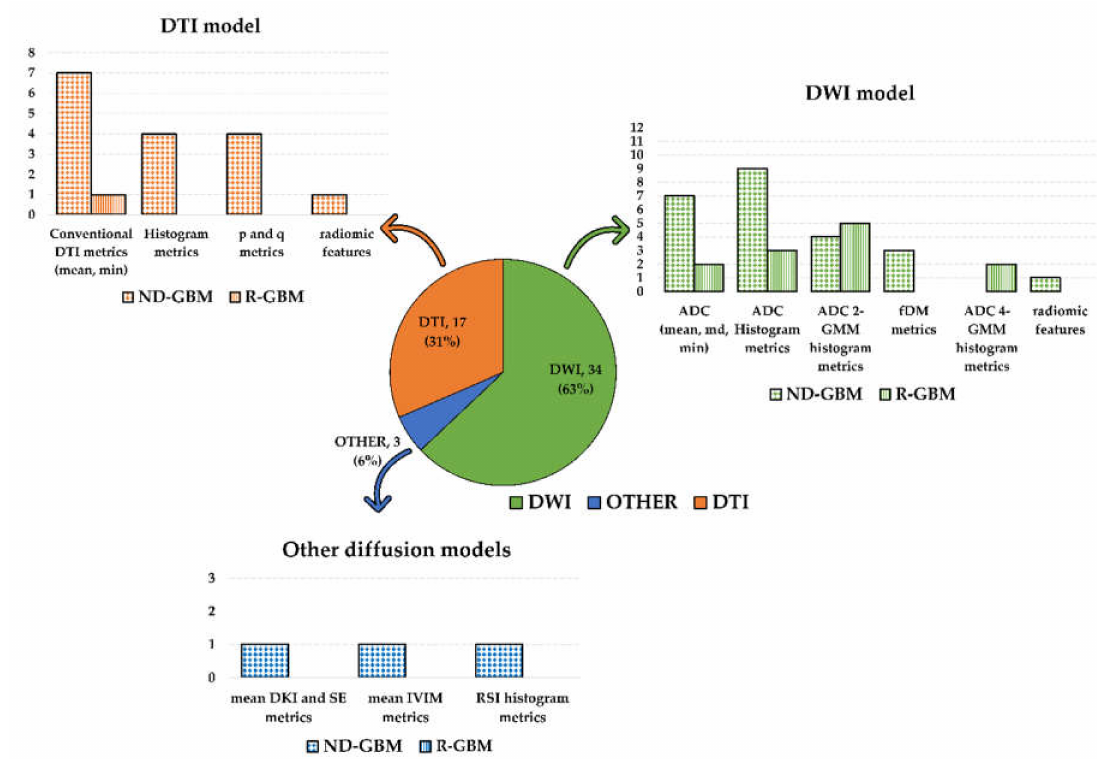
Figure 2. Graphic summary of the systematic review results according to the di ff usion models and metrics investigated in the selected studies. The pie chart shows the number of included studies according to the di ff usion MRI model (DWI in green; DTI in orange; other di ff usion models in blue). Number and percentage of studies included in each of the three groups were reported. The bar plots show the di ff usion metrics investigated in each group. Dotted bars count studies on newly diagnosed GBM patients, while the bars filled with vertical lines count studies on recurrent GBM patients. The study by Wen et al. [55] was counted three times in the DWI model histogram since they investigated both histogram and ADC 2-GMM and fDM